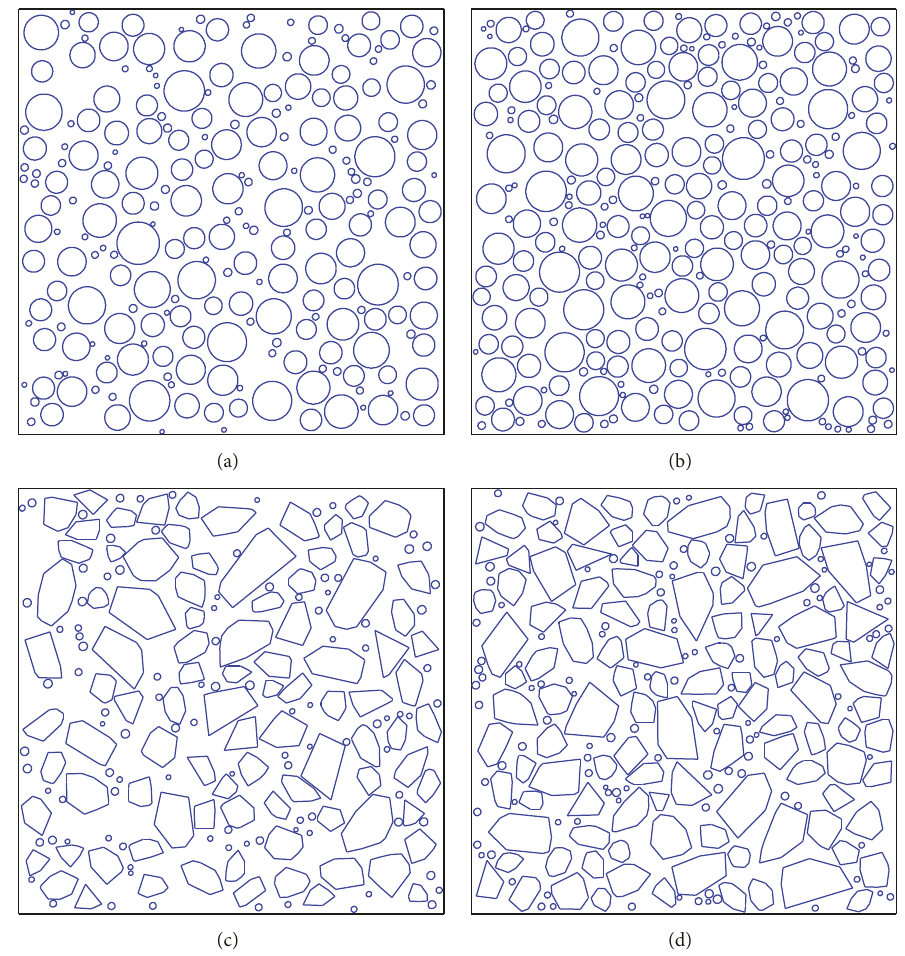
Figure 1: Numerical concrete specimens. (a) Circular aggregate ( 𝐴 𝐹 = 40 %, 𝐴 V = 2 %). (b) Circular aggregate ( 𝐴 𝐹 = 50 %, 𝐴 V = 2 %). (c) Polygonal aggregate ( 𝐴 𝐹 = 40 %, 𝐴 V = 2 %). (d) Polygonal aggregate ( 𝐴 𝐹 = 50 %, 𝐴 V = 2